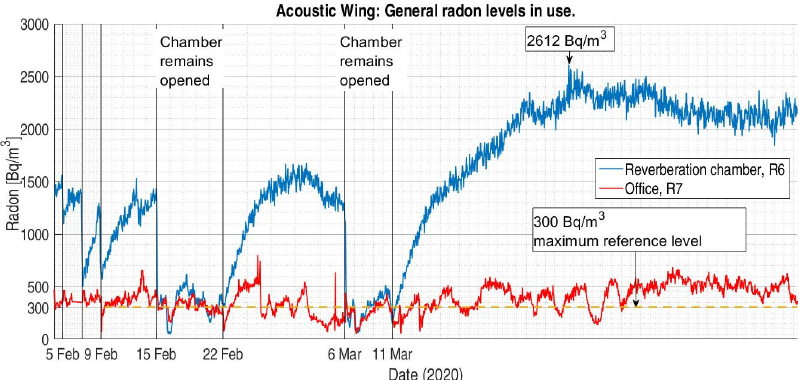
Figure 11. Radon levels in the acoustic wing during a usual labor period. The World Health Organ- isation proposes a maximum reference radon level of 300 Bq/m 3 to avoid health hazards.